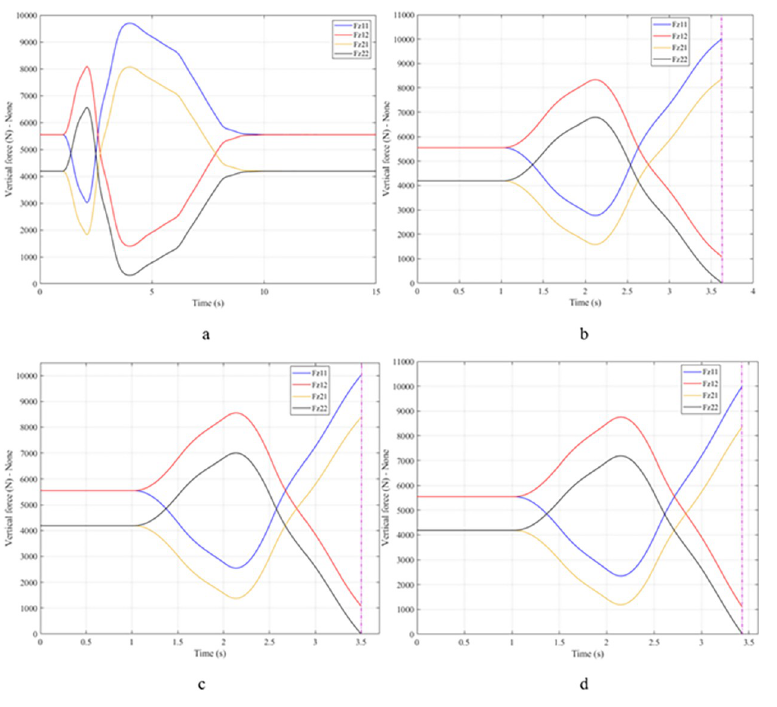
Fig 18. Vertical